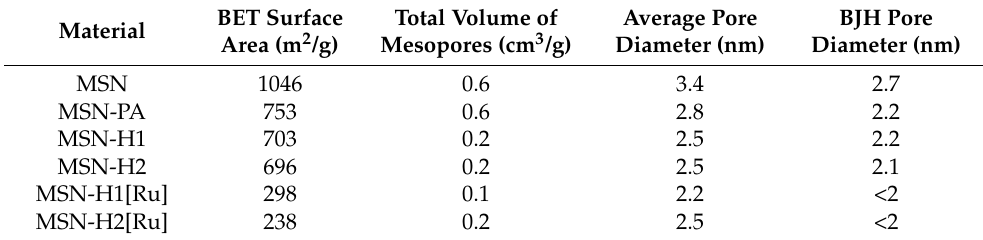
Table 1. BET surface area, mesopore volume values, average and BJH pore diameter. Material